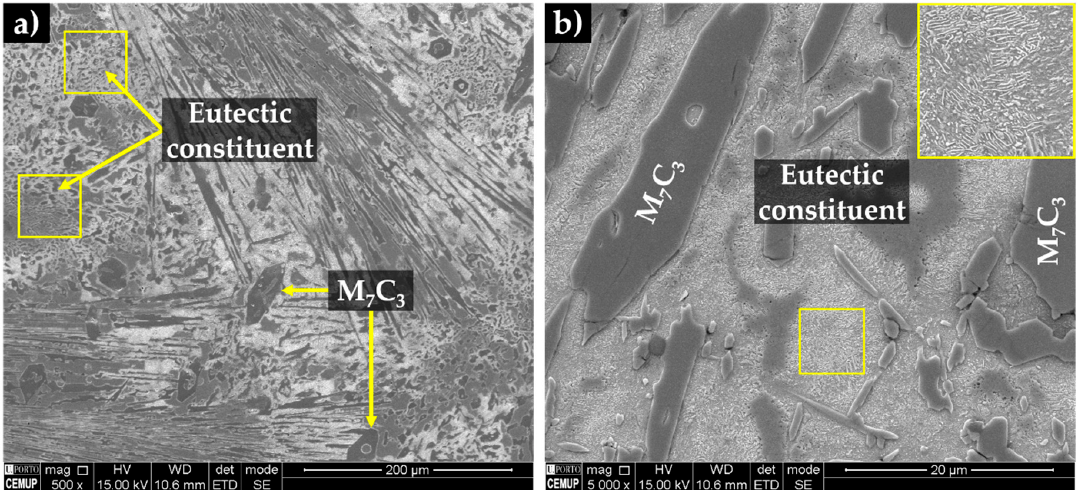
Figure 7. SEM-secondary electron (SE) image of the microstructure of the high-Cr WCI in the as-cast condition ( a ), and at higher magnification ( b ).